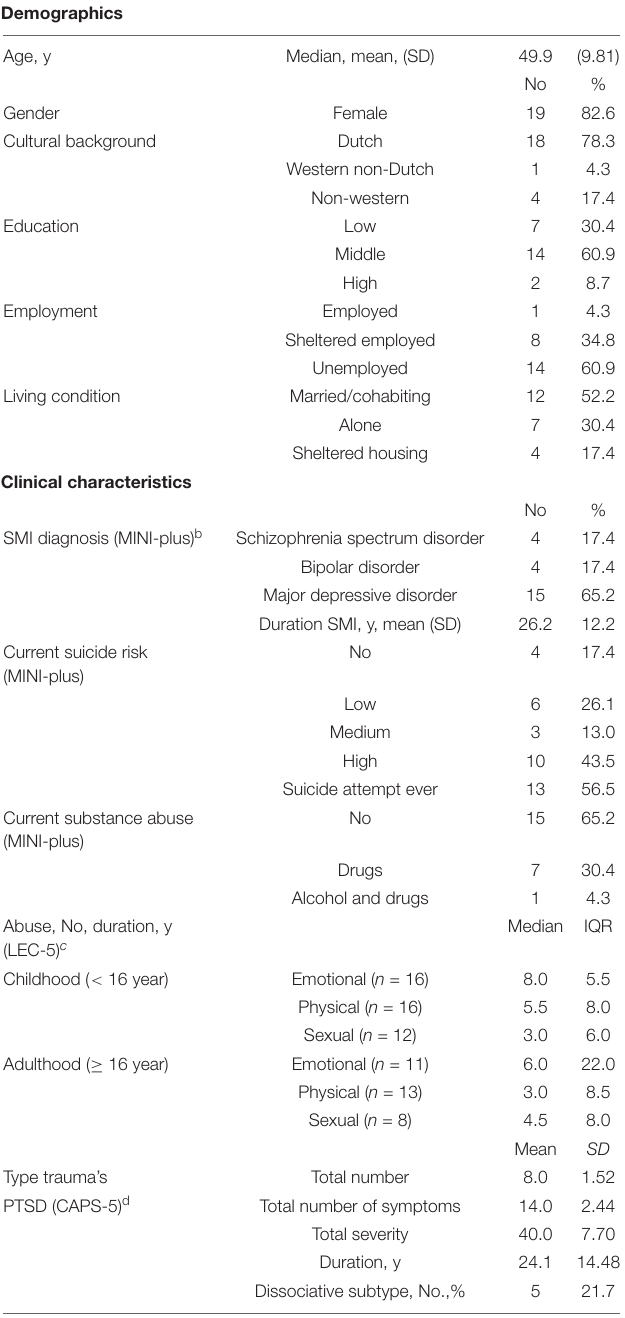
TABLE 1 | Demographic and clinical characteristics ( n = 23).